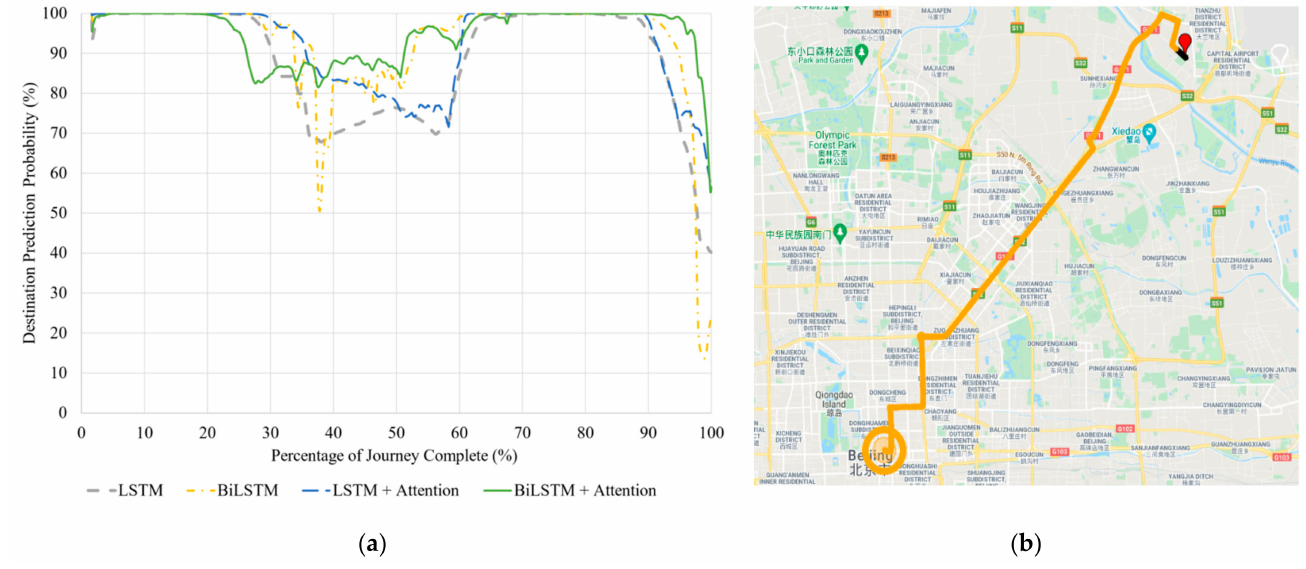
Figure 6. ( a ) Correct destination prediction certainty versus percentage complete for the seen journey to Destination 5. ( b ) BiLSTM with Attention destination predictions visualized along the same route. The red pin is the starting point. Map data © 2021. Table 8. Percent of journey correct for all models tested against the seen journey to Destination 5.